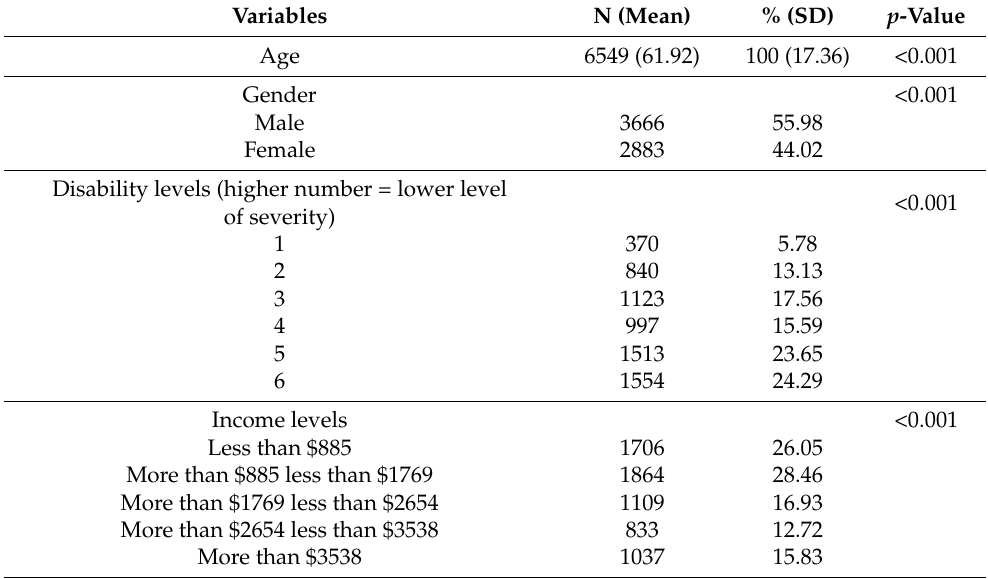
Table 1. Characteristics of study